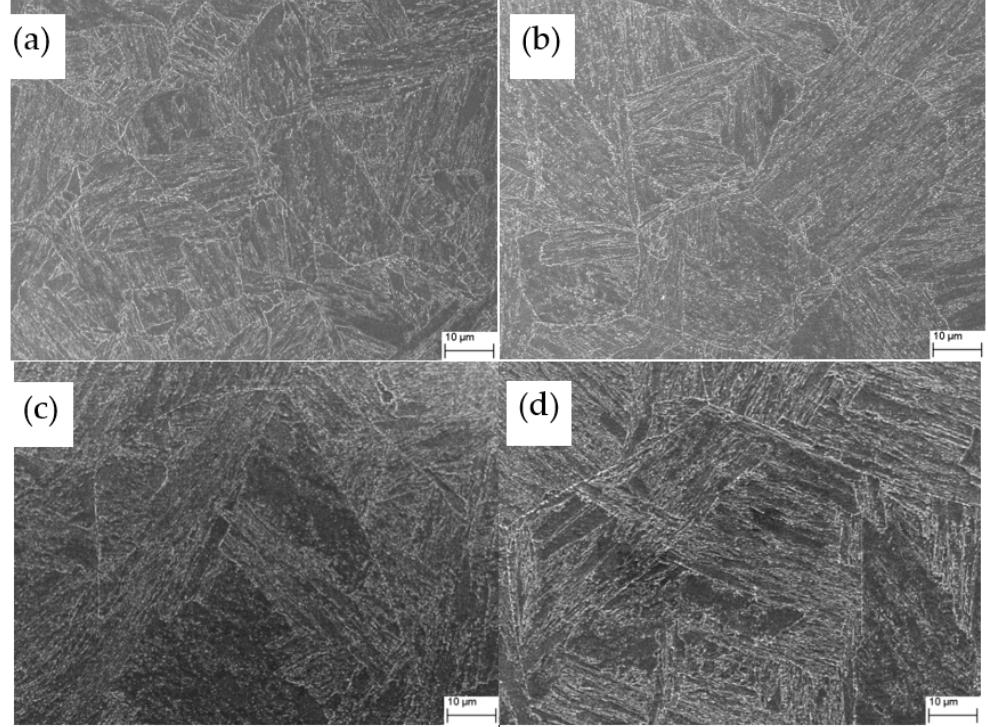
Figure 5. SEM micrographs of samples with different austenitizing temperatures: ( a ) A880; ( b ) A930; ( c ) A1050; and ( d ) A1100.